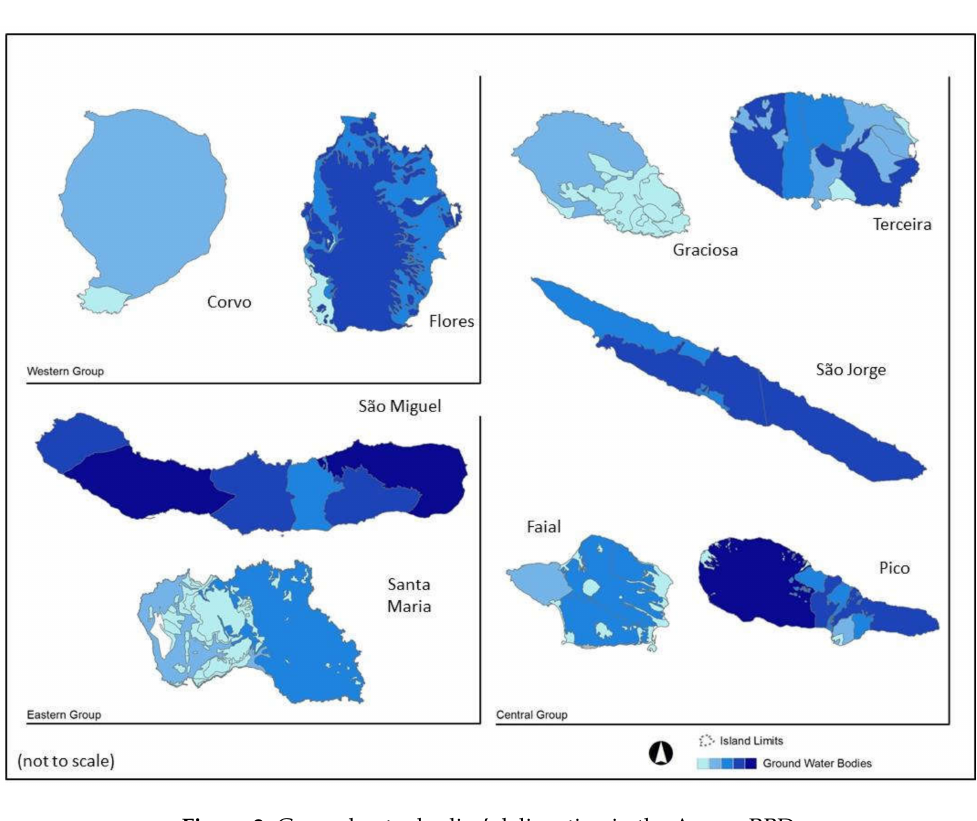
Figure 2. Groundwater bodies’ delineation in the Azores RBD.